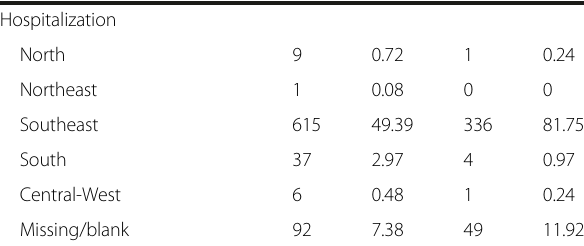
Table 1 Absolute number and percentage of confirmed spotted fever cases and deaths regarding probable area of infection, relation to work, exposure to risk environments and hospitalization, between 2007 and 2015 in